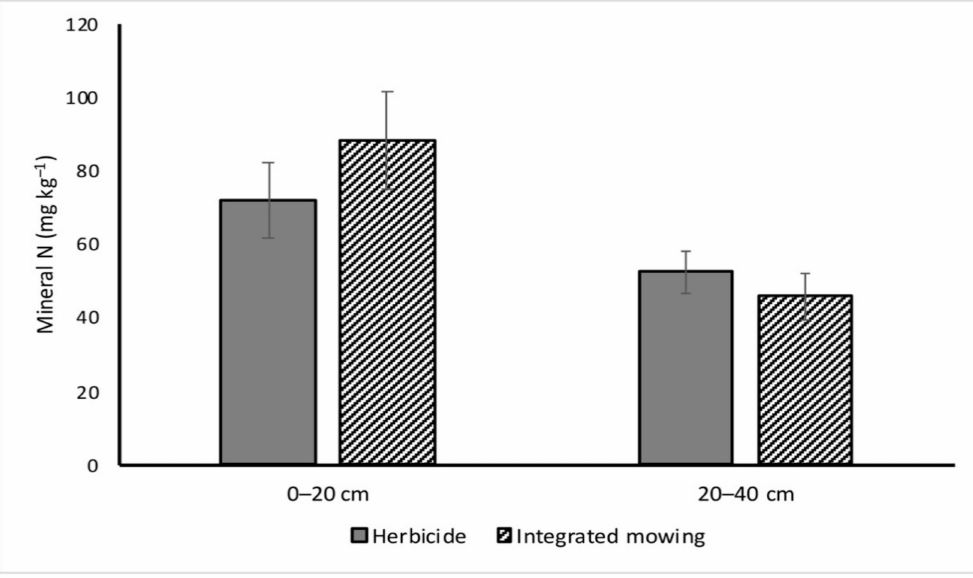
Figure 4. Interaction e ff ects of treatment and soil depth on available mineral N in both apple and peach orchards. Bars represent the standard